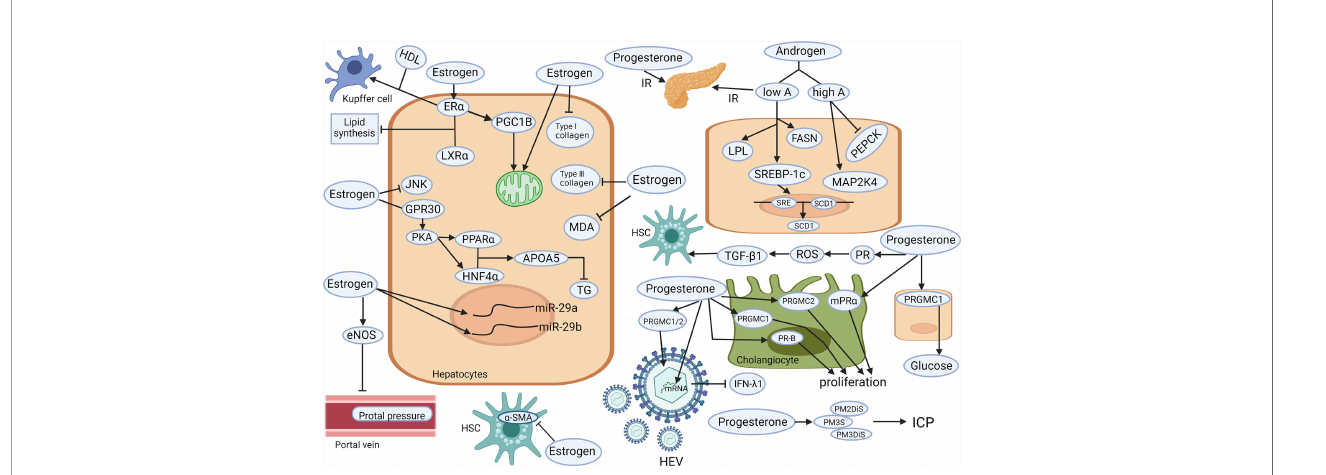
FIGURE 1 | Known mechanisms of the hepatoprotective and hepatotoxic effects of sex hormones (androgen, estrogen, and progesterone) on different liver cell types. Low level of testosterone increases the activity of LPL. The up-regulation of SREBP-1c and FASN lead to liver lipid deposition and aggravated insulin resistance. Those changes, together with the down-regulation of PEPCK and up-regulation of MAPK may lead to steatosis. Estrogen increases the content and oxidation capacity of mitochondria in hepatocytes. PGC1B promotes mitochondrial biogenesis. Estrogen also inhibits the activation of JNK and GPR30 to co-activate PKA and enhance liver PPAR a and HNF4 a to increase APOA5 expression and reduce TG. Estrogen (via its receptor alpha) induce cholesterol ef fl ux from Kupffer cells with HDL. Estrogen can restore the expression of miR-29a/b to reduce the deposition of type I and III collagen, MDA, and a -SMA, to reduce liver fi brosis and other types of liver damage. Estrogen can also signi fi cantly reduce portal vein pressure by stimulating eNOS expression. Elevated progesterone leads to insulin resistance, stimulates PGRMC1 to increase hepatic glucose production, stimulates PGRMC1/2 to promote HEV replication, and inhibits IFN- l 1 expression. In addition, the accumulation of progesterone metabolites (PM2DiS, PM3S, PM3DiS) will increase the risk of ICP. Progesterone stimulates PR-B, PRGMC1, and PRGMC2 to facilitate bile duct cell proliferation. It also causes ROS environment via its receptor signaling, resulting in TGF- b 1-activated HSC. APOA5, apolipoprotein A5; a -SMA, alpha-smooth muscle actin; eNOS, endothelial nitric oxide synthase 3; ER a , estrogen receptor alpha; FASN, fatty acid synthase; HDL, high-density lipoprotein; HSC, hepatic stellate cell; GPR30, G protein-coupled receptor 30; HNF4 a , hepatocyte nuclear factor 4-alpha; ICP, Intrahepatic cholestasis of pregnancy; IFN- l 1, type III interferon- l 1; JNK, Jun N-terminal kinase; LPL, lipoprotein lipase; IR, insulin resistance; LXR a , liver X receptor alpha; MAPK, mitogen-activated protein kinase; MDA, malondialdehyde; mPR a , membrane progestin receptor alpha; PEPCK, phosphoenolpyruvate carboxykinase; PGC1B, proliferator-activated receptor gamma coactivator 1B; PGRMC, progesterone receptor membrane component; PKA, protein kinase A; PM2DiS/PM3DiS/PM3S, progesterone metabolites; PPAR a , peroxisome proliferator-activated receptor alpha; PR, progesterone receptor; ROS, reactive oxygen species; SCD1, stearoyl-CoA desaturase1; SRE, sterol regulatory element; SREBP-1c, sterol regulatory element-binding protein-1c; TG, triglyceride; TGF, transforming growth factor (Created with Biorender.com with a publication